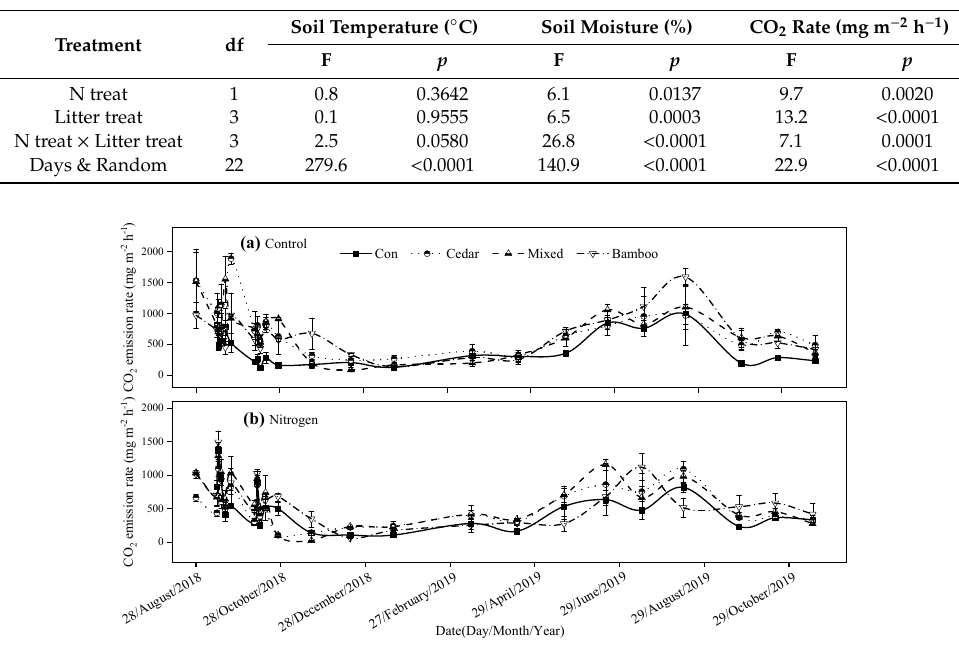
Figure 1. Soil CO 2 emission dynamics as affected by N deposition (a, Control; b, N deposition) and different fine root litter treatments over 14-month in situ study. Con, no root litter; Cedar, cedar fine root litter; Bamboo, bamboo fine root litter; Mixed, mixed fine root litter by both Cedar and Bamboo at 1:1